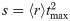
(A)Maximum GFP induction for 7 select experiments as a function of the effective AHL production constant s=〈r〉tmax2. The sender strength parameter s in the experiments was varied via the sender/receiver ratio r. Nominally, the initial ratios were chosen to be r = 0.067, 0.142, 0.33, and 1 (corresponding to sender fractions of 6.25%, 12.5%, 25%, and 50%, resp.), but due to cell division and dynamics within the bacterial traps, the ratios varied over time—the resulting average ratios 〈r〉 are indicated for the single data points. Error bars represent standard deviations obtained from single cell gene expression histograms as in Fig 3. (B) Determination of effective AHL concentration for the 7 experiments using the calibration curve acquired in the ‘receiver only’ experiments with constant [AHL]. (C) The parameter s and the effective AHL concentration in the traps can be related as indicated by the broken lines in part A and B of the figure (for the red colored example point). A linear fit to the data following Eq (6) is shown as a red line, error bars are obtained from the standard deviations in (A) via error propagation. (D) Example image of a microfluidic trap containing sender (red) and receiver (green) bacteria.